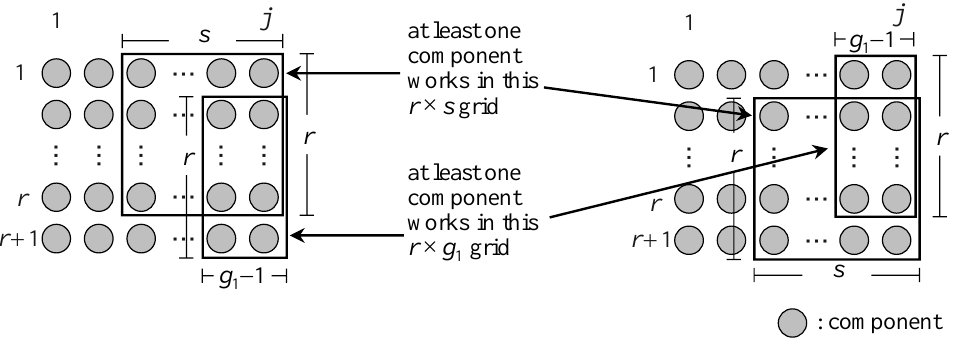
Fig. 3. Example of two systems which have the same conditions